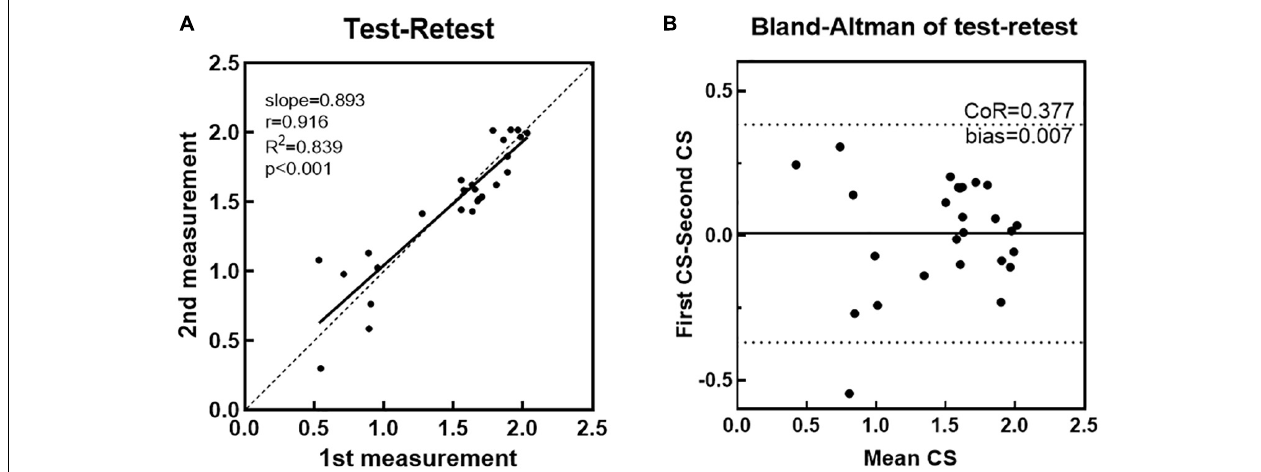
FIGURE 7 | (A) LogCS measured on the second run plotted against those obtained in the first run. The Pearson correlation coefficient (r) between two runs was 0.916. Linear regression was performed to evaluate the test–retest reliability. (B) The Bland–Altman plot shows the differences (first CS - second CS) between sensitivity estimates obtained from each eye tracking measure, plotted against their mean (first CS + second CS/2). Each dot represents 1 data point. The central solid line indicates the mean difference (bias) between different measures. Dotted lines indicate the 95% agreement upper and lower limit